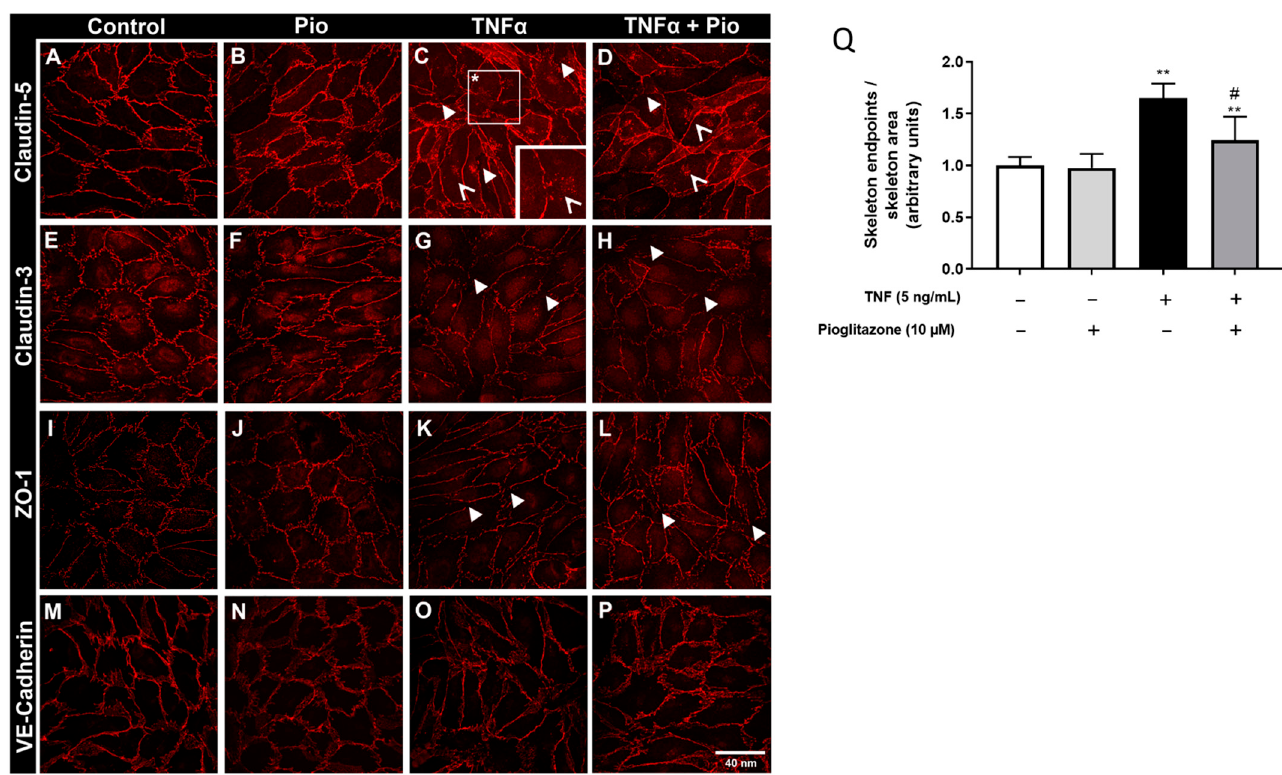
Figure 4. Effects of pioglitazone on TNF α -induced disarrangement of junctional proteins. BLECs were treated with 5 ng/mL of TNF α for 24 h following pre-treatment with 10 µM pioglitazone for 24 h. Filters from transwell inserts were collected, antibody-stained and mounted on glass slides. Visual inspection of organization of junctional proteins was assessed by immunofluorescence under a confocal microscope (100×) ( A – P ). Immunofluorescence images of claudin-5 were processed on CellProfiller ® software, and skeleton endpoint ratios (total “filled” skeleton area by the actual skeleton area) were assessed ( Q ). Scale bar = 40 nm. Thick white arrowheads represent segments of claudin-5 discontinuation; thin white arrowheads represent points of claudin-5 resorption; the image at the corner in C represents a higher magnitude (500×) amplifying the area denoted by a white box containing an asterisk. Results are shown as mean ± standard deviation (n = 4) and were analyzed via one-way ANOVA followed by Tukey’s post hoc test. ** p < 0.01 in comparison to control groups; # p < 0.05 in comparison to TNF α -treated group.